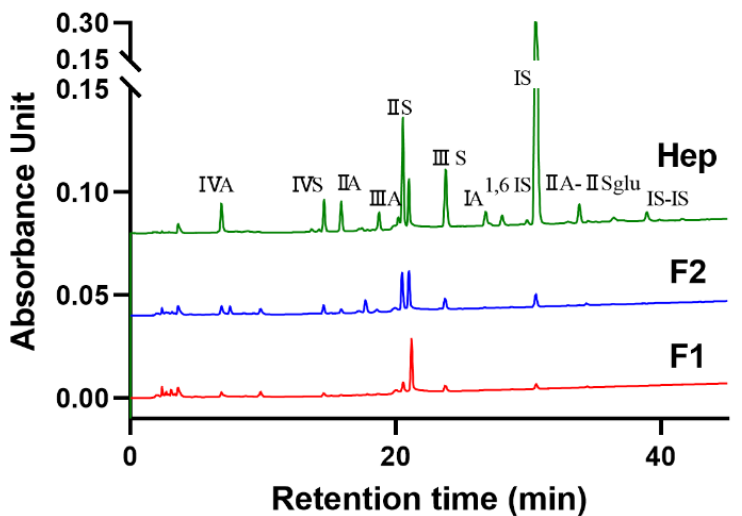
Figure 2. Disaccharides composition of heparinoid F1 and F2 by SAX-HPLC; IVA ( ∆ UA-GlcNAc), IVS ( ∆ UA-GlcNS), IIA ( ∆ UA-GlcNAc6S), IIIA ( ∆ UA2S-GlcNAc), IIS ( ∆ UA-GlcNS6S), IIIS ( ∆ UA2S- GlcNS), IA ( ∆ UA2S-GlcNAc6S), IS ( ∆ UA2S-GlcNS6S), IIA-IISglu ( ∆ UA-GlcNAc6S-GlcA-GlcNS3S6S). Table 1. Analysis of disaccharides composition of F1 and F2.